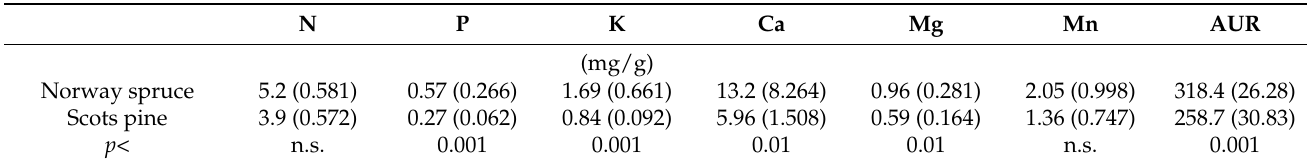
Table 1. Average concentrations of nutrients and AUR in local needle litter of Scots pine, and Norway spruce. There was a total of 14 stands of Norway spruce and 17 of Scots pine. Standard deviation in parenthesis. Significant differences are given. Data from [4,5,46]. N P K Ca Mg Mn